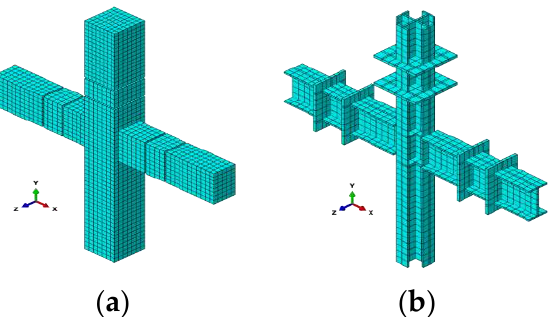
Figure 7. Finite element analysis model: ( a ) mesh dividing for the concrete ( b ) mesh dividing for the steel plate. Comparison results can be found in Figure 8, where the solid line and dotted line represent experimental results and numerical computation results,